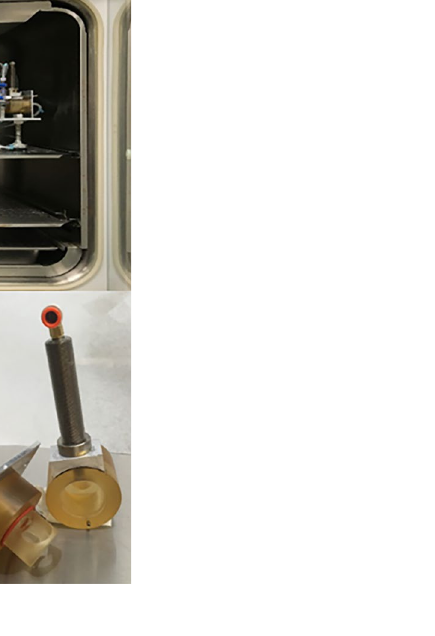
Figure 1. Ex-vivo bone bioreactor